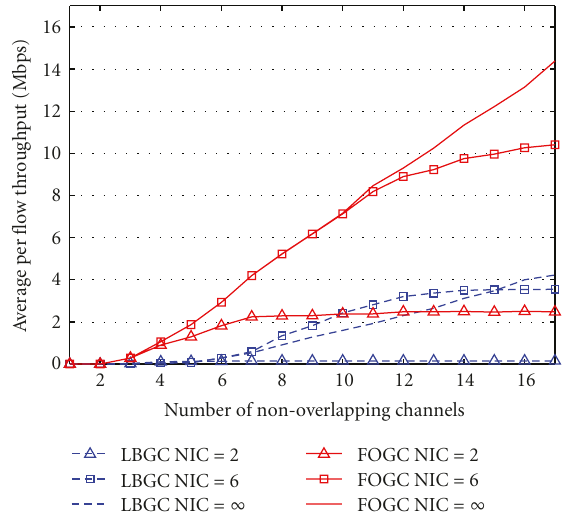
Figure 4: Compare FOGC, LBGC, and the optimal solution in an 8-node ring topology. Figure 5: Compare FOGC and LBGC in a 10 × 10 grid topology with three 8-hop